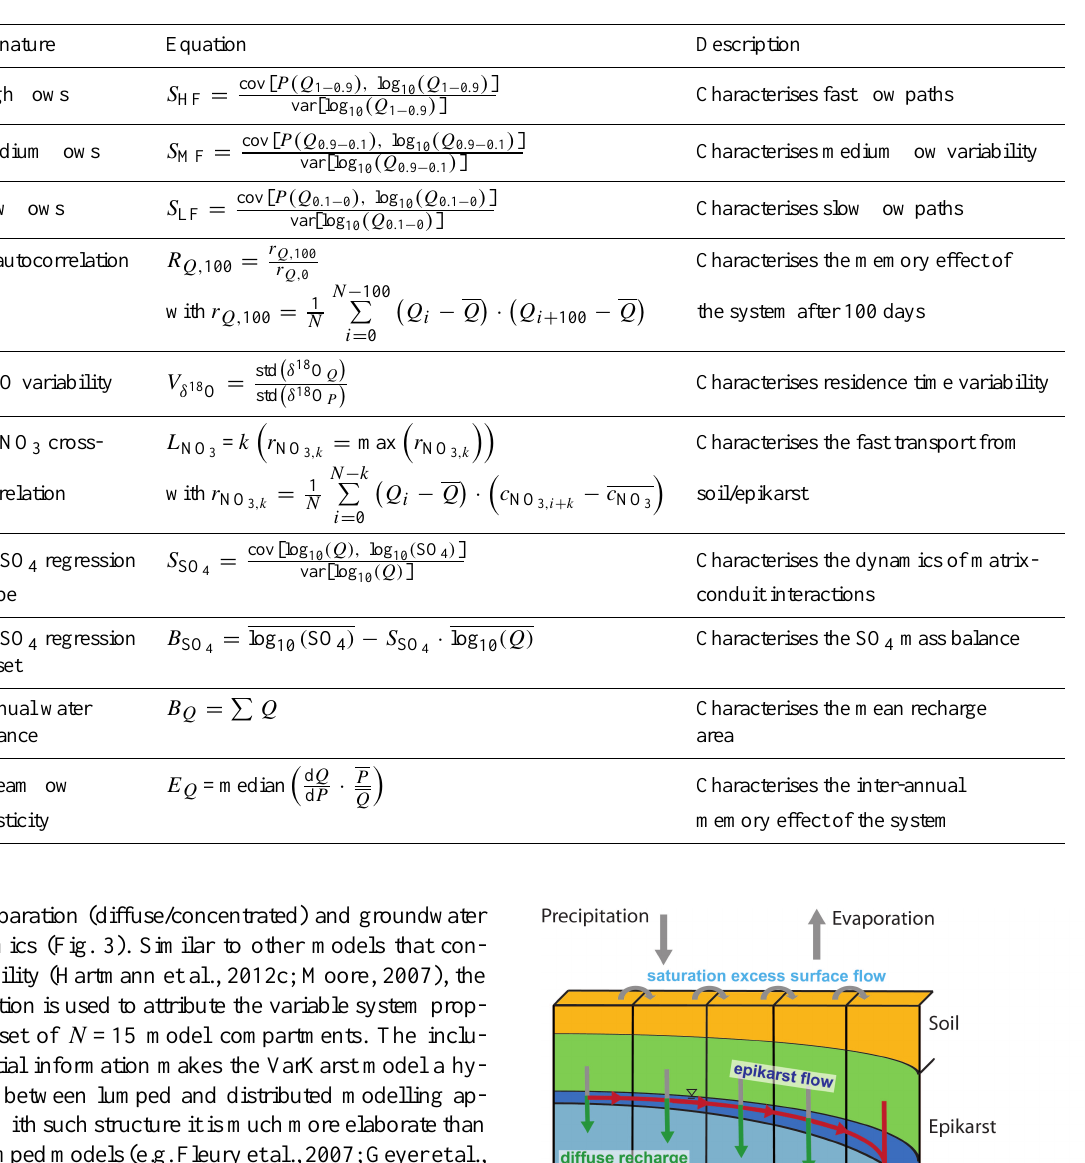
Table 3. Karst-specific system signatures, their equations and description (cov: covariance, var: variance, std: standard deviation, P(X y ) : exceedance probability of variable X at the probability interval y , N : number of time steps, log 10 : decadal logarithm, dX : inter-annual change of annual variable X ).